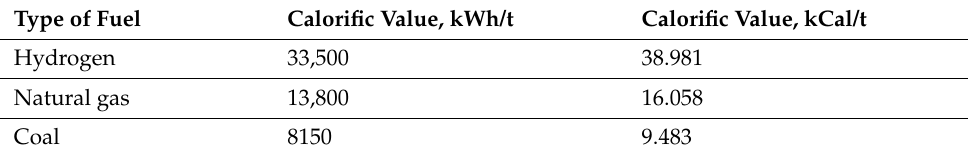
Table 1. Comparative characteristics of the calorific value of various fuels. Type of